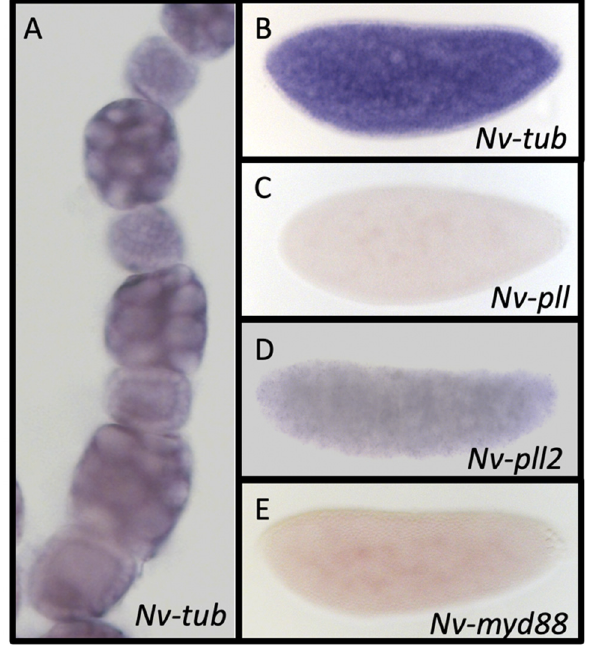
Figure 6. Membrane-associated components’ expression in ovaries and embryos. ( A ) Nv-tub is expressed in nurse cells, oocytes, and follicle cells from early stages of oogenesis onward (early stage shown). ( B – D ) Membrane-associated components ( B ) Nv-tub , ( C ) Nv-pll , ( D ) Nv-pll2 , and ( E ) Nv- myd88 are ubiquitously expressed throughout early embryogenesis (mid blastoderm stages shown).